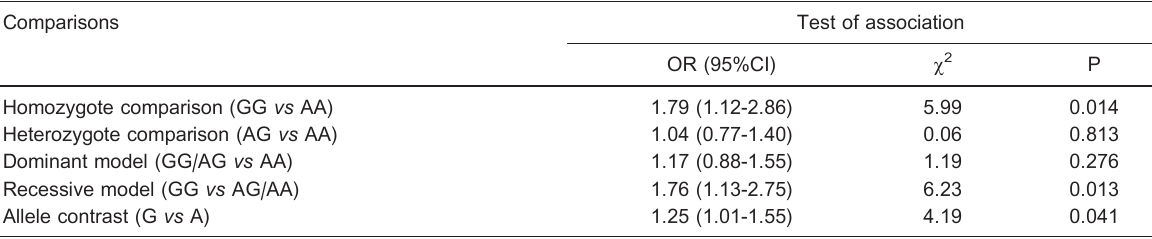
Table 3. Association between esophageal cancer risk and the c.910A . G genetic variant of the XRCC1 gene.